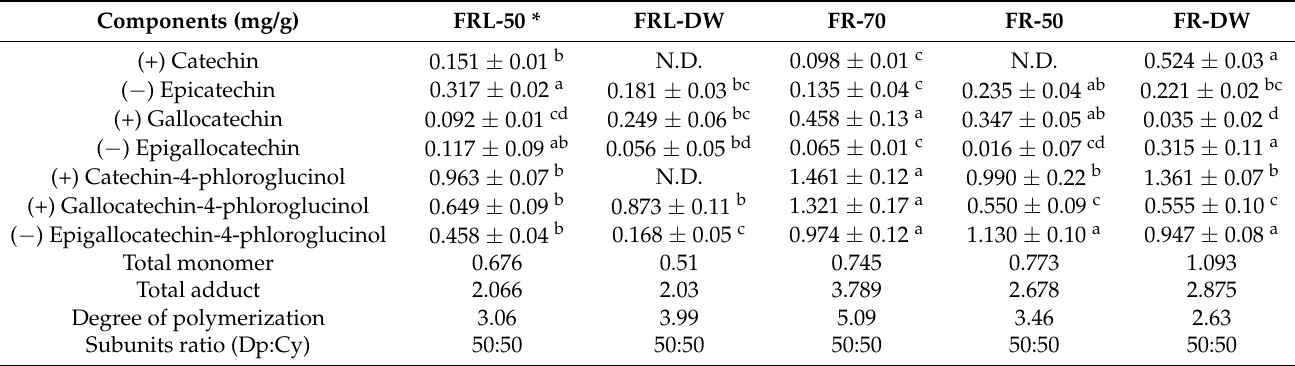
Table 1. Composition of oligomers of proanthocyanidins in F . racemosa and F. religiosa